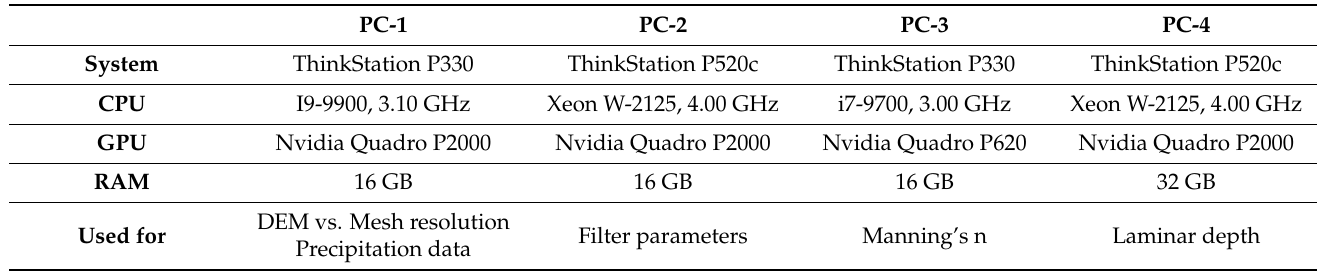
Table 3. Hardware configurations used in the